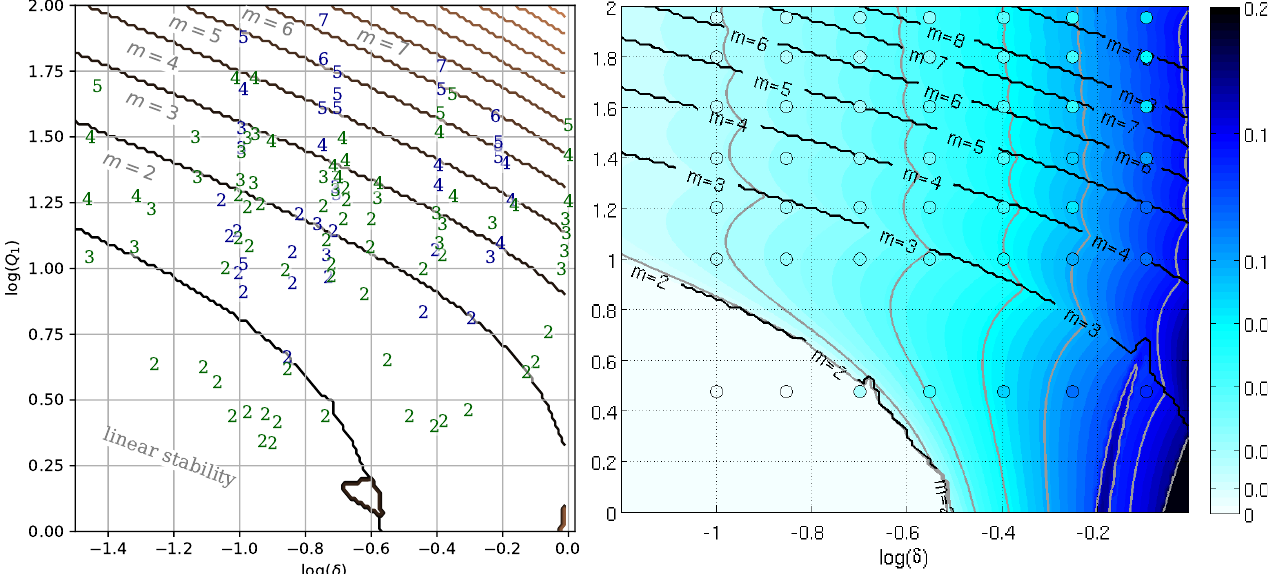
Figure 5. Left panel : wavenumbers of the most unstable modes from the linear stability analysis (contours) and observed in laboratory experiments (text). Green labels are reproduced from (Griffiths and Linden [16], their Figure 5), and blue labels are from our set of experiments. Contours in the lower left part of the panel has been removed for visibility, using the condition σ > 2 × 10 − 2 for modes higher than m = 2 in this region of the ( δ , Q 1 ) space. Right panel : comparison of the growth rate predicted by linear theory (colours) and measured in the numerical experiments (colored bullets) in the ( δ , Q 1 ) parameter space (zoomed over the range of δ values investigated in the nonlinear